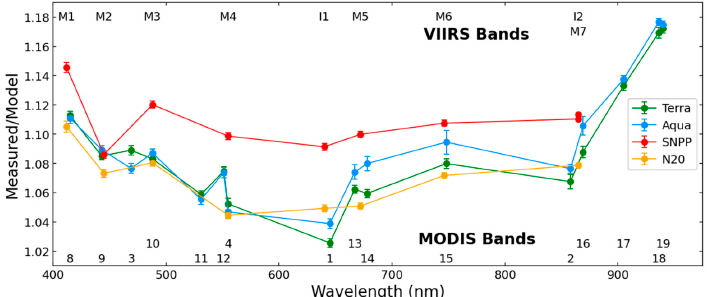
Figure 9. Ratio of the measured data and the ROLO model data as a function of wavelength for the VIS/NIR bands in both MODIS and VIIRS. The ratios are taken from data between 1 January 2018 and 1 July 2022 as shown in Figure 8. The error bars show the standard deviation. With the exception of small residual uncertainties among different lunar phases and libration angles, the absolute uncertainty of the lunar model is cancelled in this lunar cal- ibration inter-comparison. In this study, we have used a large number of lunar observa- tions made at nearly the same phase angles and the impact due to small residual uncer- tainties in the lunar model is therefore minimized. Presented in Tables 3–5 are the lunar calibration inter-comparison results for Terra and Aqua MODIS, SNPP and N20 VIIRS, and Aqua MODIS and N20 VIIRS, respectively, using their regularly scheduled lunar ob- servations made between 1 January 2018 and 1 July 2022. The results for SNPP and N20 VIIRS and for Aqua MODIS and N20 VIIRS include a correction (Equation (11)) to remove the impact due to different solar spectra used in their on-orbit calibration. It requires no additional correction for Terra and Aqua MODIS lunar calibration inter-comparison as both use the same solar spectra. The calibration differences (DIF) in these tables, expressed in percentage (%), were computed using the averages of measured/predicted ratios of the same (or matching) spectral bands from the two instruments (i.e., DIF = ( 𝑅 (cid:3002)/(cid:3003)∗ − 1) × 100). The standard deviations reported in the tables are the combined values based on their time-series. Table 3. Lunar calibration inter-comparison results for Terra and Aqua MODIS (WL: wavelength; DIF: difference (Terra—Aqua); STD: standard deviation; UC: uncertainty). The values are listed as a percentage and the uncertainties were propagated from the values for each instrument/band listed in Table 6.